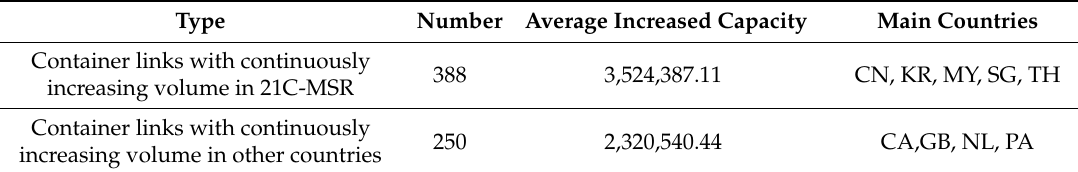
Table 4. Links with continuously increasing container